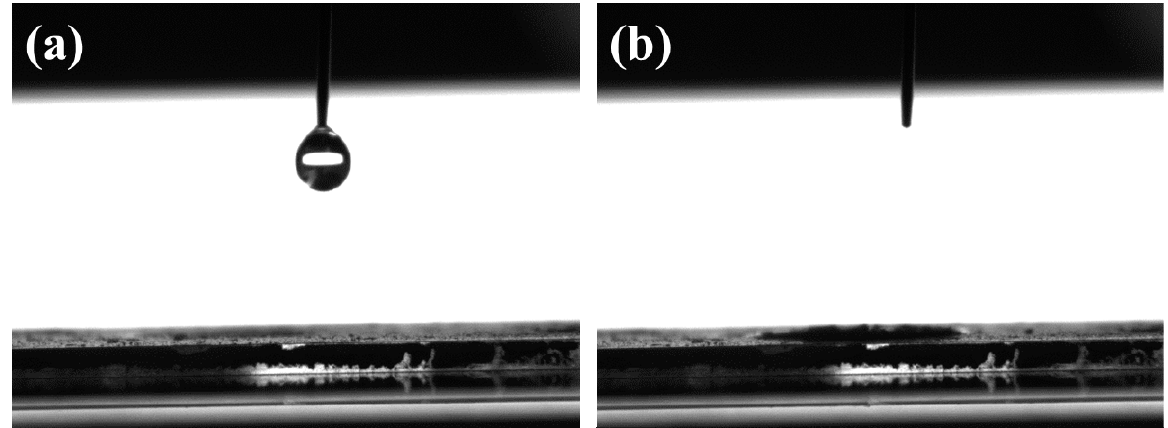
Figure 5. WCA for the AC/Fe 2 O 3 nanocomposite ( a ) before and ( b ) after release of a water droplet.